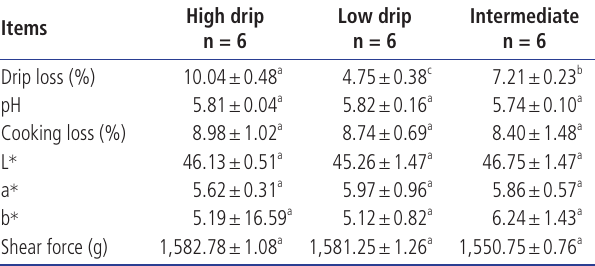
Table 1. Meat quality of chicken muscles in high, low and intermediate drip loss